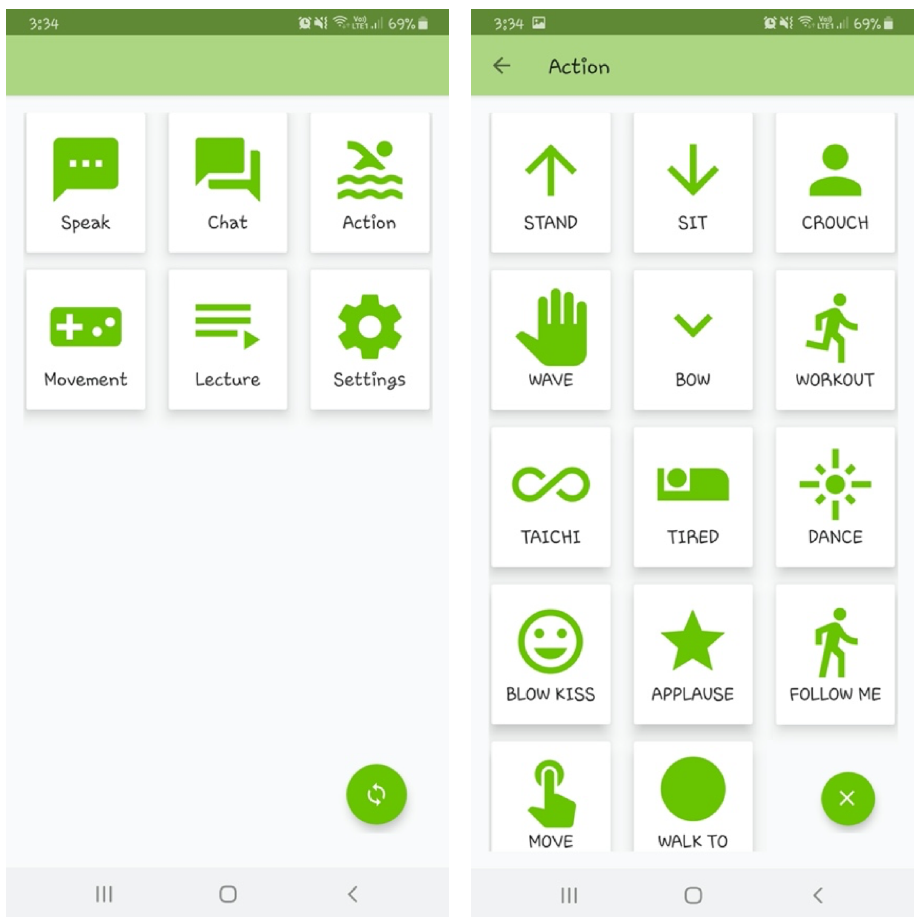
Figure 2. Main screen ( left ) and Action module ( right ) of the MAX app. The arrows in the bottom right corner of the main screen are used to ‘refresh’ the wireless connection, and the ‘x’ in the bottom right corner of the Action module stops the current activity running on the